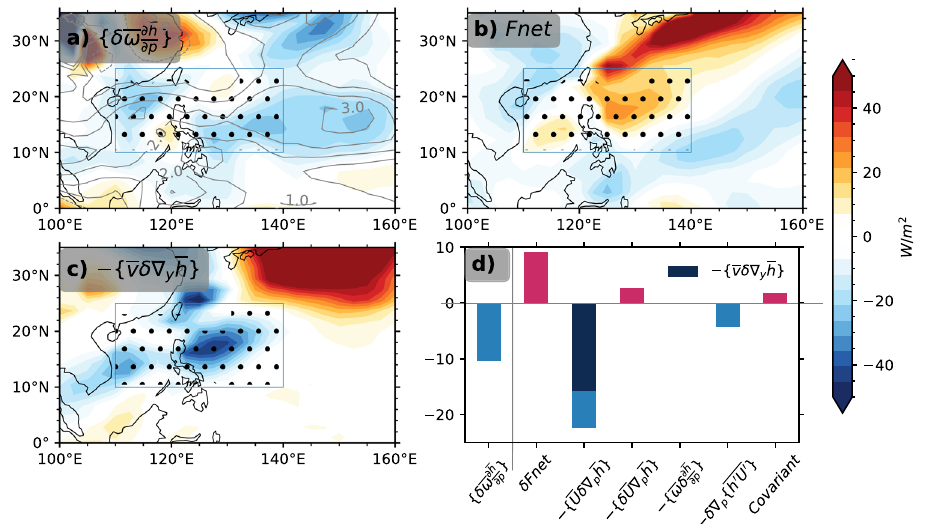
Fig. 3 MSE budget analysis for the autumn WNPAC. a Column-integrated vertical MSE-advection anomaly (shading) associated with vertical motion change and vertical p -velocity anomaly (contour, Pa/s); b net energy source change from top of the atmosphere and surface; c column-integrated horizontal MSE-advection anomaly associated with meridional MSE-gradient change; d region-averaged anomalous MSE budget terms. In a – c , the dots (cid:1) (cid:3) correspond to anomalous descending fl ow. In d , the region is de fi ned as [10 – 25°N, 110 – 140°E] as the box in a – c . The (cid:1) (cid:1) v (cid:3) δ ð ∇ y (cid:1) h Þ (legend, dark blue) (cid:4) (cid:5)n o (cid:1) (cid:3) is almost zero. See context and Methods for dominates the horizontal MSE-advection anomaly (cid:1) (cid:1) u (cid:3) δ ð ∇ p (cid:1) h Þ , and (cid:1) (cid:1) ω (cid:3) δ ∂ (cid:1) h ∂ p